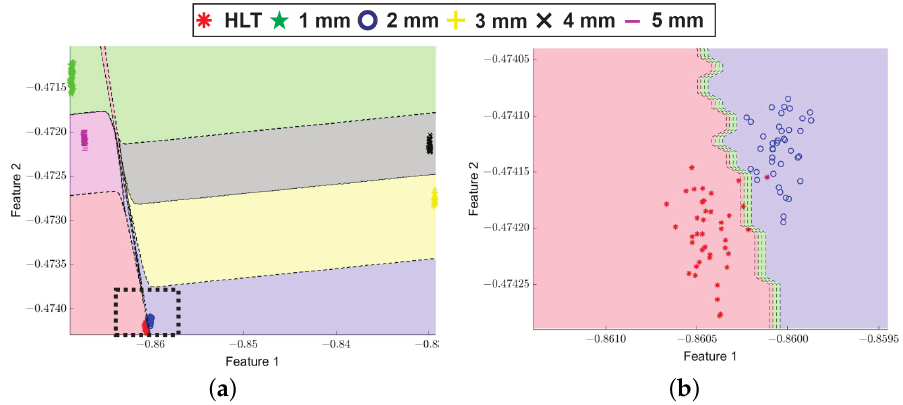
Figure 14. Projection of the decision regions for the multiple fault classification computed by the proposed FFNN-based classifier when the induction motor is driven at 5 Hz by using a VFD: ( a ) Complete view of the projection. ( b ) Zoomed view of the black rectangle